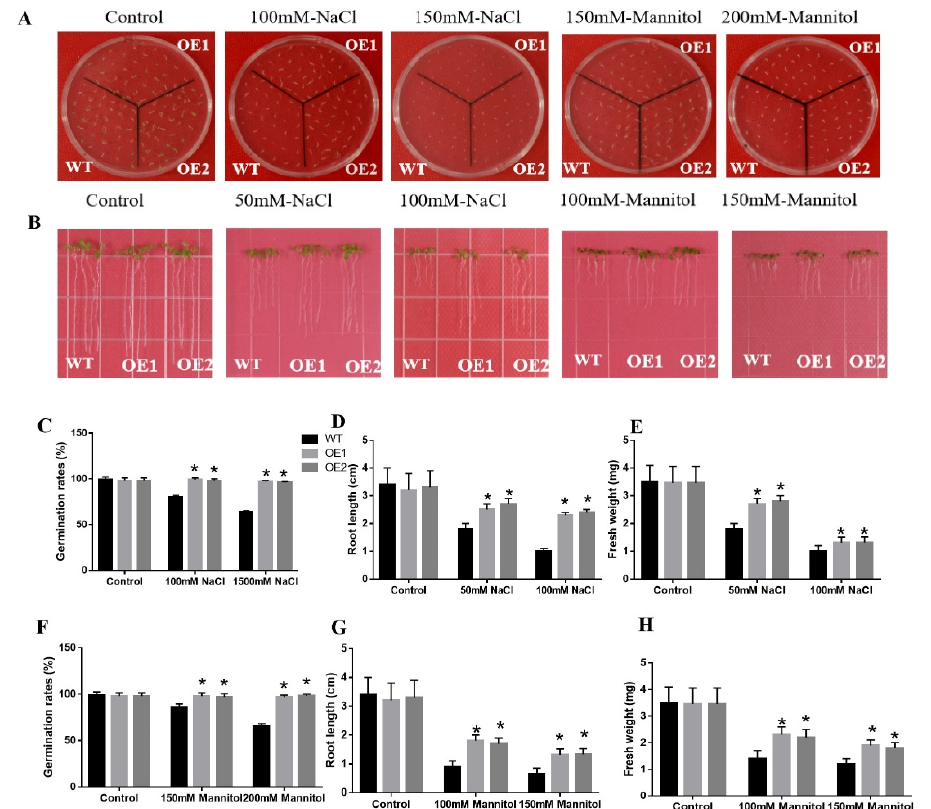
Figure 5. Analyses of salt and osmotic resistance of CaDHN3 -overexpressed transgenic Arabidopsis and WT Arabidopsis plants. ( A ) Phenotypes of seed germination rates. ( B ) Root lengths. ( C , F ) Germination rates. ( E , H ) Fresh weights. ( D , G ) Root lengths. Mean and S.D. values were obtained from three independent experiments. Asterisks indicate statistical significance (* p < 0.05, Student’s test) compared to control.